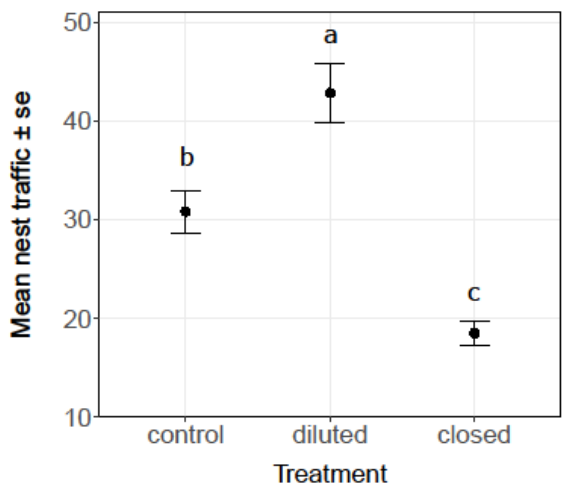
F IGURE 2. Mean proportion of B. terrestris returning to the colony with pollen from each treatment group in the 30-minute colony observation periods. Circles indicate back-transformed least square means ± standard error. Means sharing the same letter are not significantly different from each other at the .05 significance level. Control treatment colonies (N = 7) had an unaltered internal nectar reservoir (60% sugar concentration), diluted treatment (N = 7) had a diluted reservoir (40% sugar concentration), and the closed treatment (N = 7) had no access to an internal nectar reservoir.